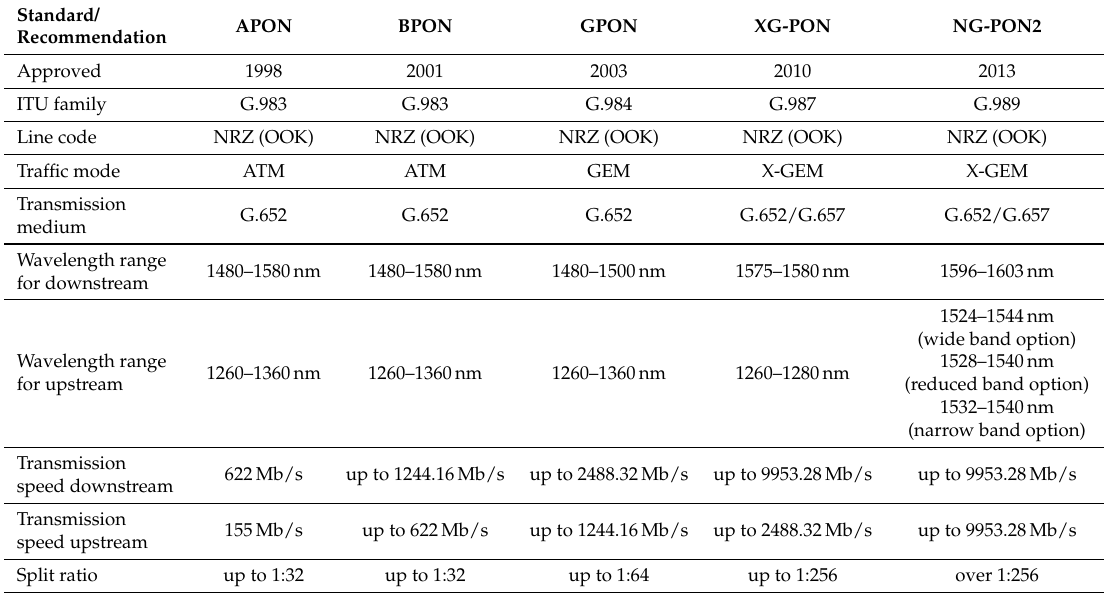
Table 2. Comparison of presented passive optical networks standards/recommendations